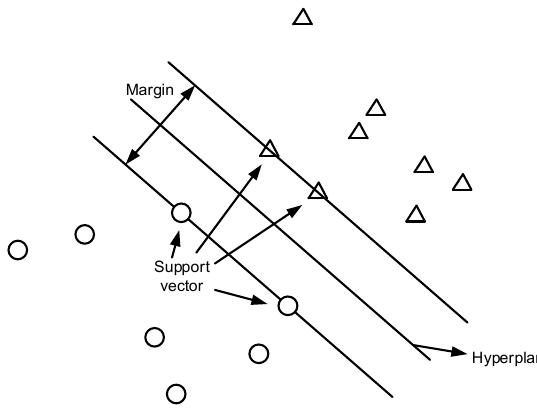
Figure 2. SVM binary classification.